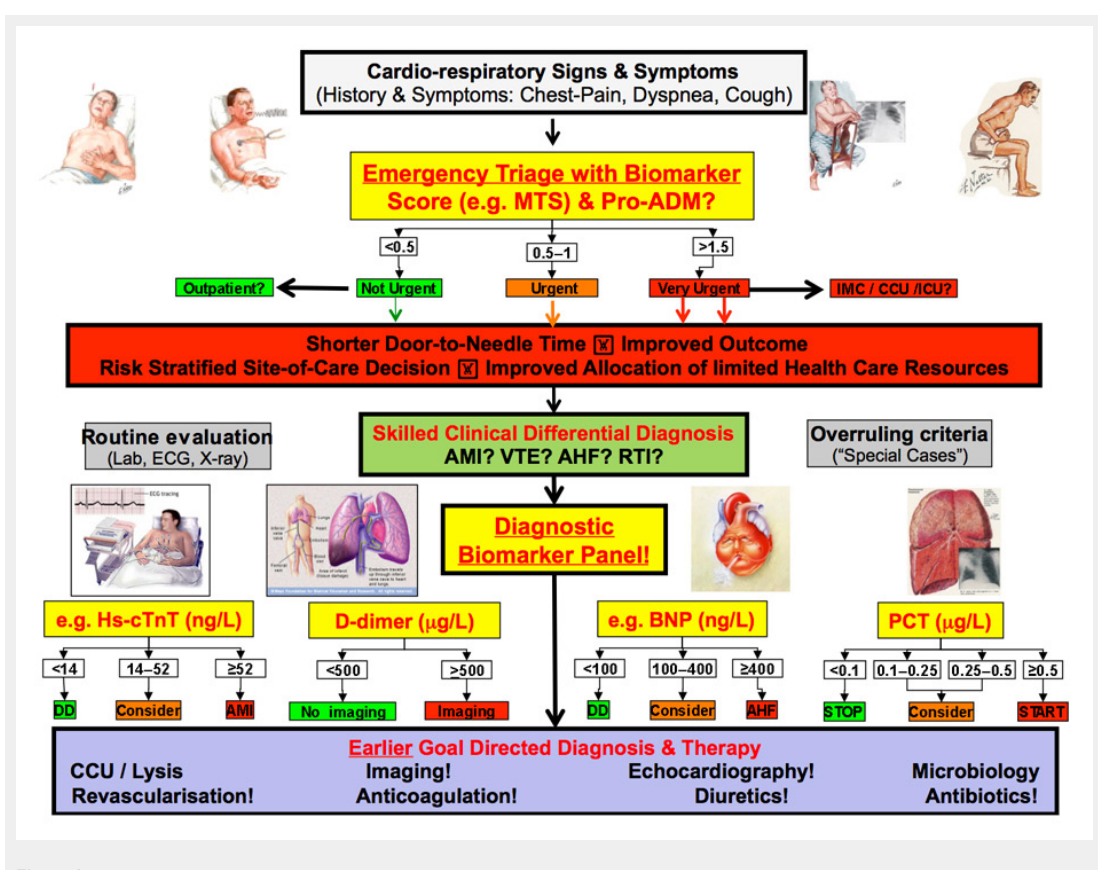
Figure 4 Personalised clinical and biomarker-guided medicine in the emergency department. POC = point of care; MTS = Manchester Triage Score; ProADM = proadrenomedullin; ICM = intermediate care; CCU = coronary care unit; ICU = intensive care unit; Lab = laboratory analysis of biomarker level; X-ray = chest radiography; ACS = acute coronary syndrome; AHF = acute heart failure; RTI = respiratory tract infections; hs = highly sensitive; DD, = differential